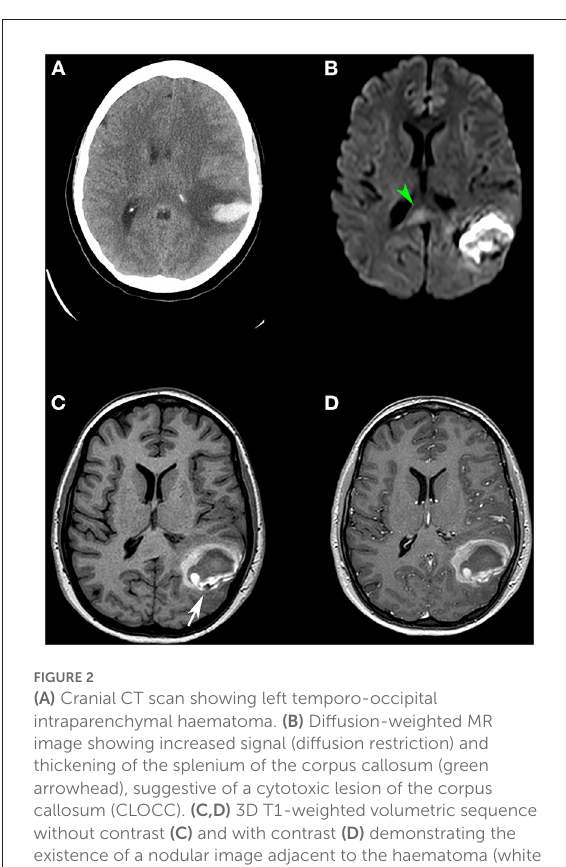
FIGURE3 (A) Selective arteriography of RICA. The presence of a pseudoaneurysm is detected at the level of the distal temporo-occipital vasculature (black arrow). (B) Angular artery supraselective arteriography. The branch presenting the pseudoaneurysm shows an irregularity of the arterial wall suggesting arteritis (black arrow). (C) Glue cast after embolization (black arrow). (D) Selective arteriography of RICA after branch embolisation. Absence of pseudoaneurysm (black arrow). (E) Selective arteriography of LVA. Compensation of the left temporo-occipital territory through temporal branches of the left vertebral artery (black asterisk) is demonstrated. (F) Diffusion weighted MR image 1 month after treatment. Morphological and signal normalization of the splenium of the corpus callosum (green arrowhead). Absence of